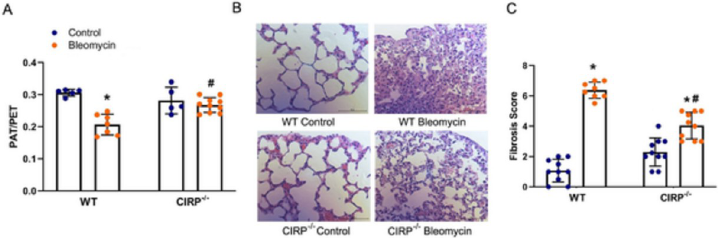
Fig 3. Deficiency in CIRP ameliorates physiological markers of fibrosis in mice exposed to bleomycin. Pulmonary acceleration time (PAT)/pulmonary ejection time (PET) ratio ( A ) was obtained which correlates with inverse right ventricular pressure (a surrogate for pulmonary hypertension). 5- μ m lung tissue fragments preserved in paraffin, and later stained with hematoxylin and eosin ( B ) were evaluated using Hu¨bner’s modification of the Ashcroft fibrosis score ( C ). Four random sites were observed and scored under light microscopy at 200x magnification; the mean score of four sites was used as the fibrosis score of each lung section. Representative samples for the lung sections are shown at 400x from Wild Type (WT) Control, WT Bleomycin, CIRP -/- Control, and CIRP -/- Bleomycin mice ( B ). � p < 0.05 vs. WT Control, # p < 0.05 vs. WT Bleomycin.